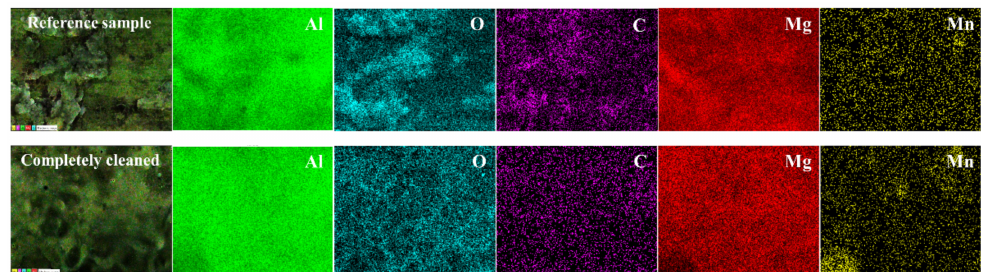
Figure 9. ( a ) Oxygen content of aluminum alloy after cleaning under di ff erent powers; ( b ) oxygen content of aluminum alloy after cleaning at di ff erent speeds.